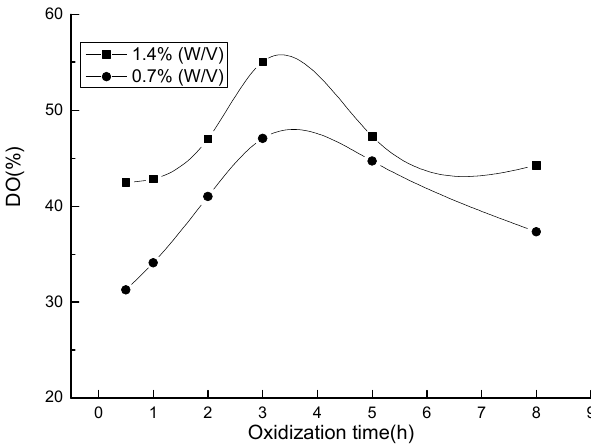
Figure 1. The e ff ect of reaction time of HNO 3 / H 3 PO 4 –NaNO 2 -mediated oxidation system on the Figure 1. The effect of reaction time of HNO 3 /H 3 PO 4 –NaNO 2 -mediated oxidation system on the oxidation degree of oxidation degree of chitosan.